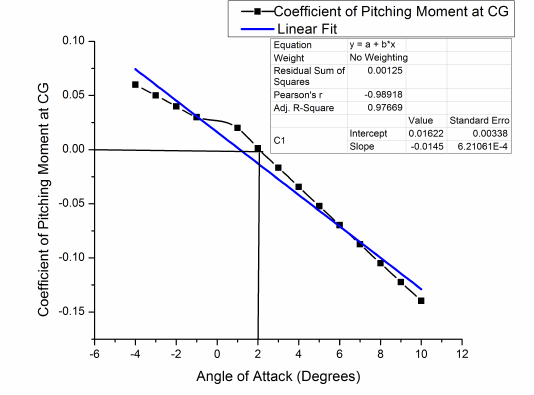
( d ) Experimental results of drag coefficient variation with angle of attack. The linear equation of nonlinear curve is approximated by the equation of tangent line to curve which has a slope of 0.0004 at trim angle of attack of 2 ◦ and shown as C D = 0.015 + 0.0004 α